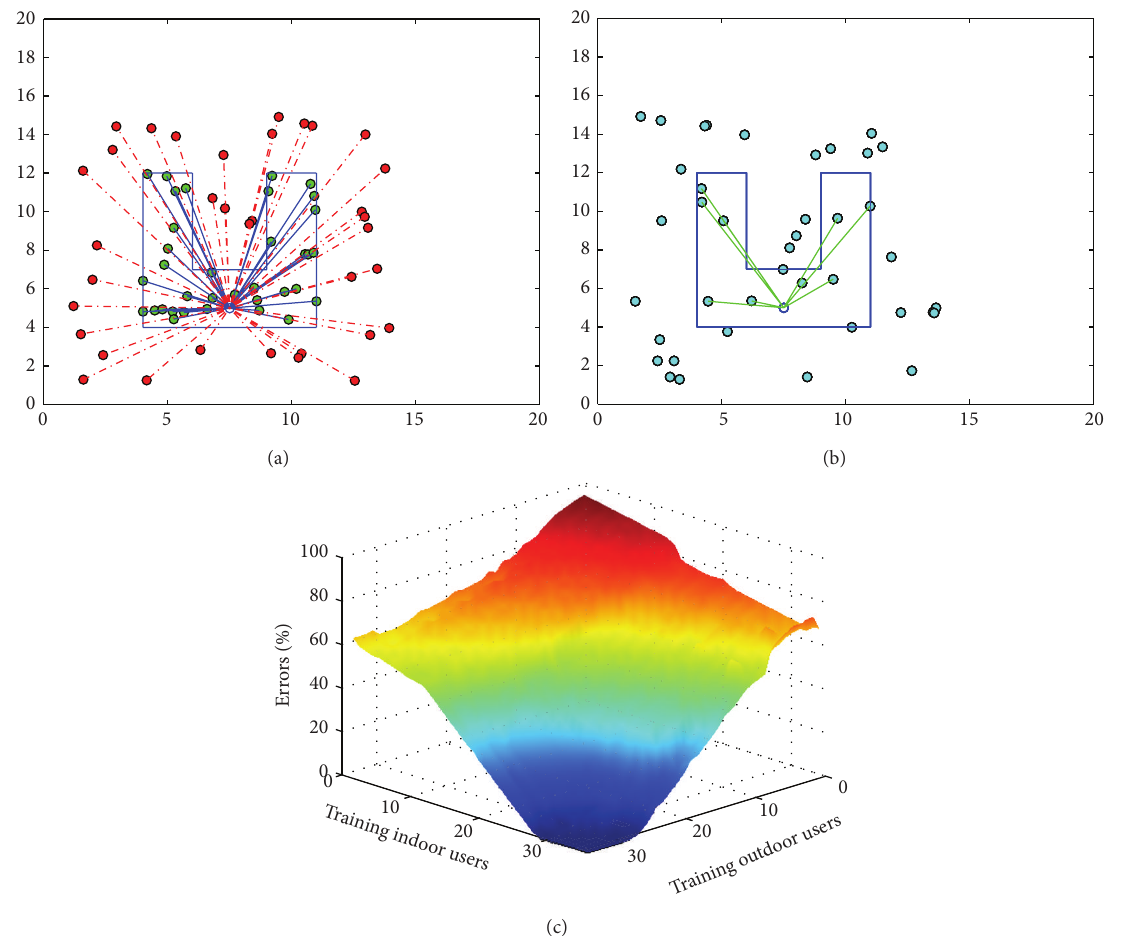
Figure 7: (a) Training and (b) testing process of the femtocell with “U” shaped house. (c) Performance of femtocell for different number of samples.